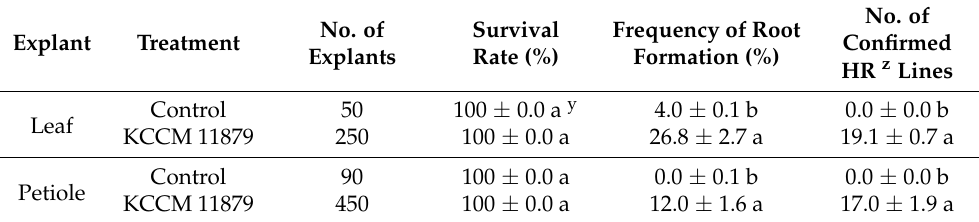
Table 1. Induction of hairy roots (HRs) from petiole and leaf explants of Centella asiatica using a 3- week-old culture of Agrobacterium rhizogenes strain KCCM11879 .